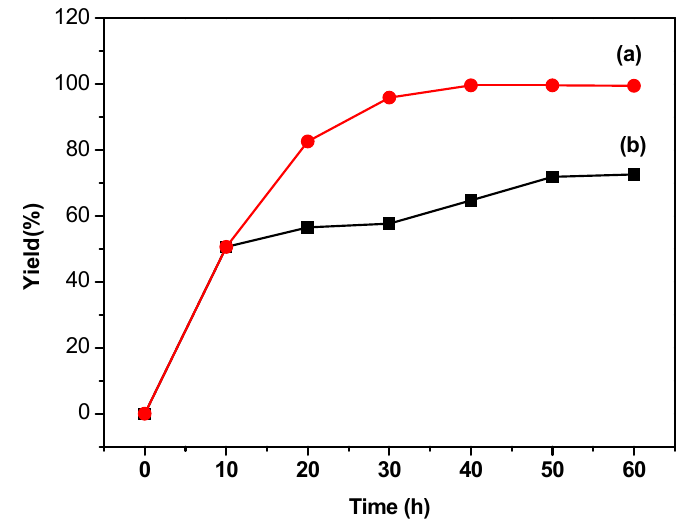
Figure 9. TEM images of fresh ZIF-8 ( A ), recovered after three cycles ( B ) and after six cycles ( C ) from the Knoevenagel condensation between 2-nitrobenzaldehyde and malononitrile in biphasic system at 40 ◦ C.